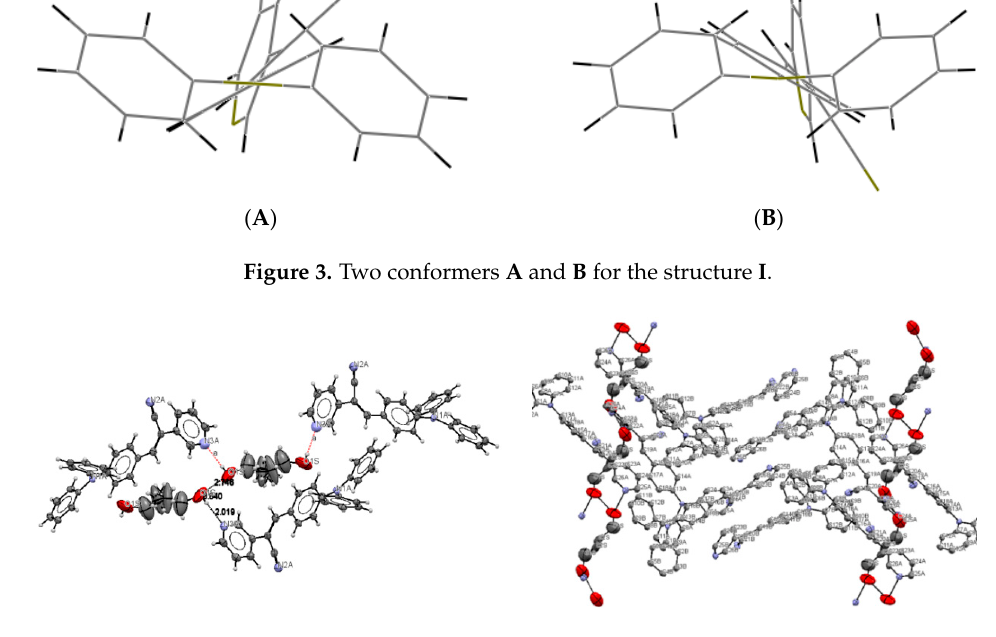
Figure 4. Intermolecular hydrogen bond interactions between the lattice solvent molecules (donor) and conformers A (acceptor).